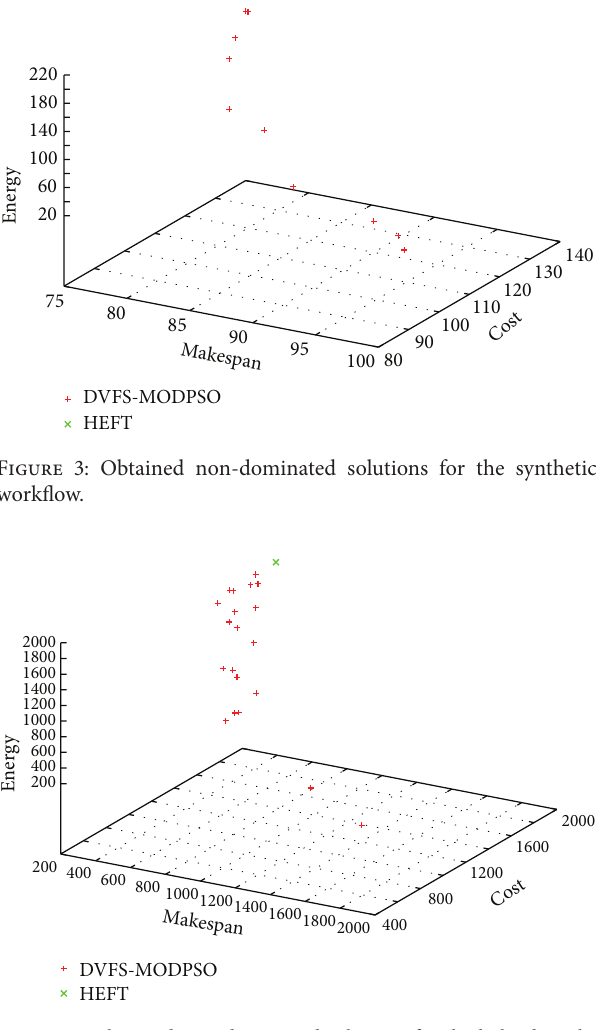
Figure 4: Obtained non-dominated solutions for the hybrid work- flow.